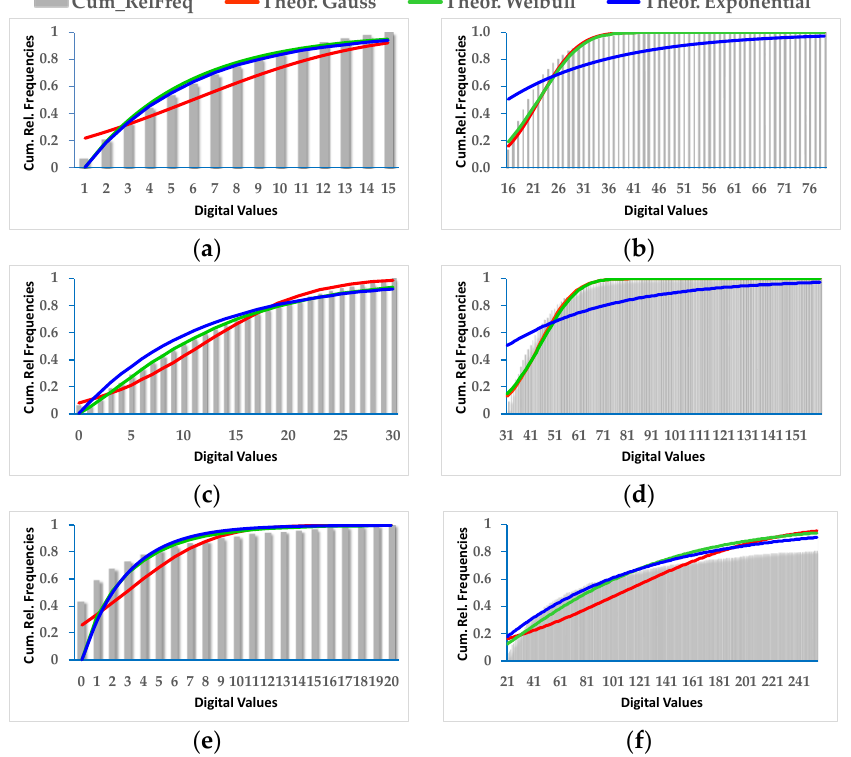
Figure 10. DS1, adjusted Gauss, exponential and Weibull probability distributions: ( a ) No_Change CDI Difference; ( b ) Change CDI Difference; ( c ) No_Change CDI Log_Ratio; ( d ) Change CDI Log_Ratio; ( e ) No_Change CDI Kb_Leibler; ( f ) Change CDI Kb_Leibler.